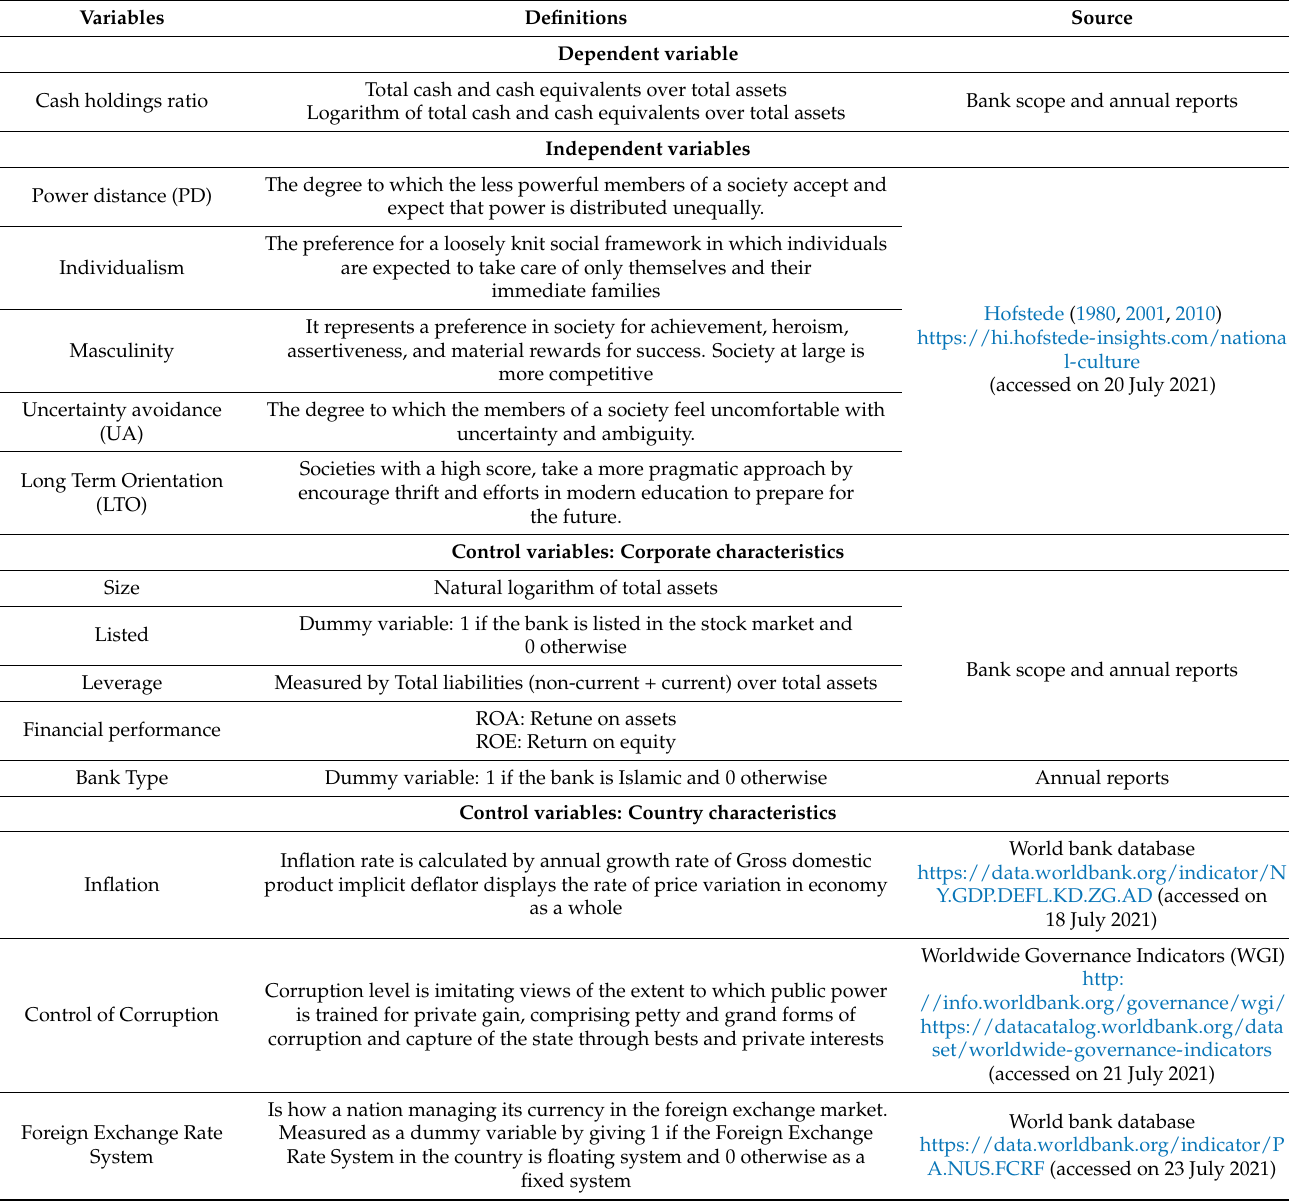
Table 1. Variables, definitions, and